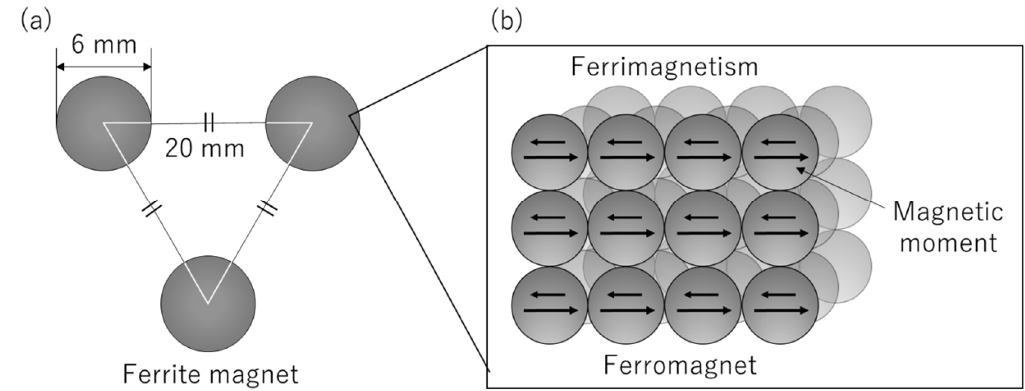
Figure 8. A ferrite magnet sample used in the measurements: schematic of the sample ( a ) and its structure ( b ).